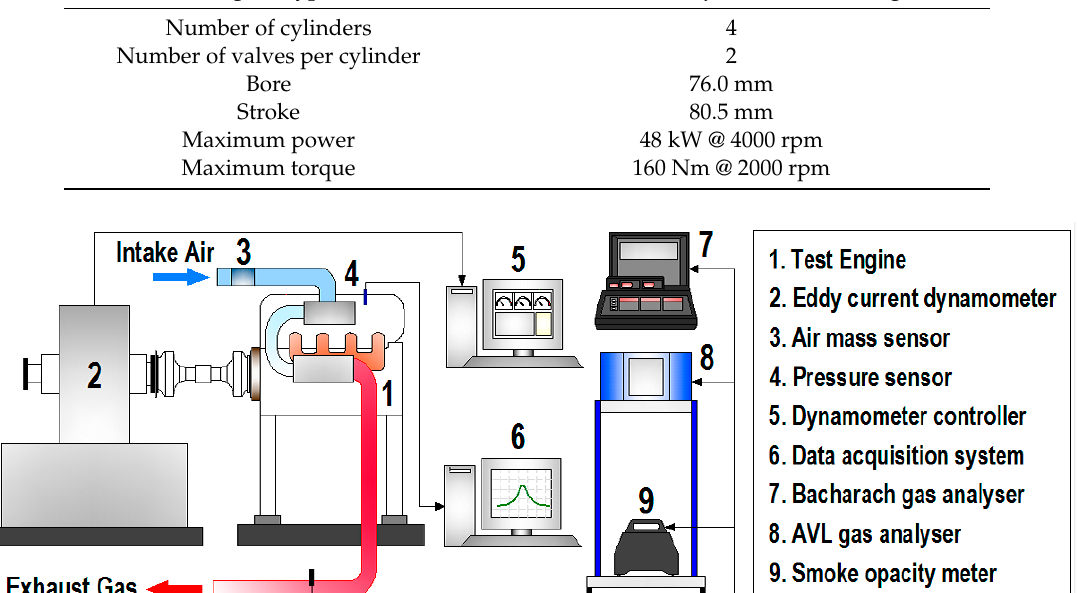
Table 3. Specifications of the test engine.